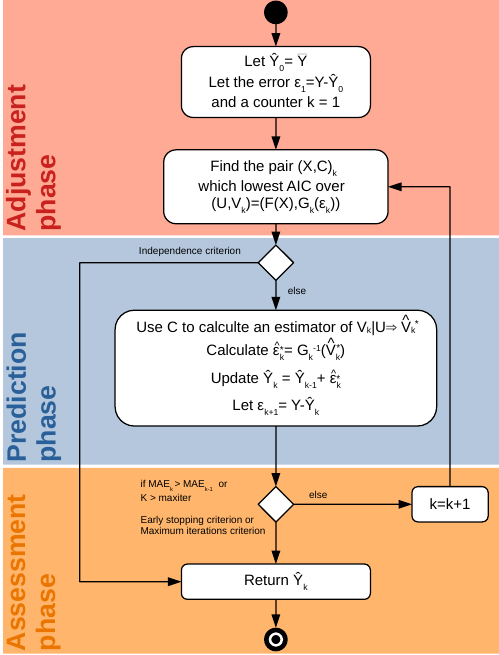
Figure 1. Copula selection